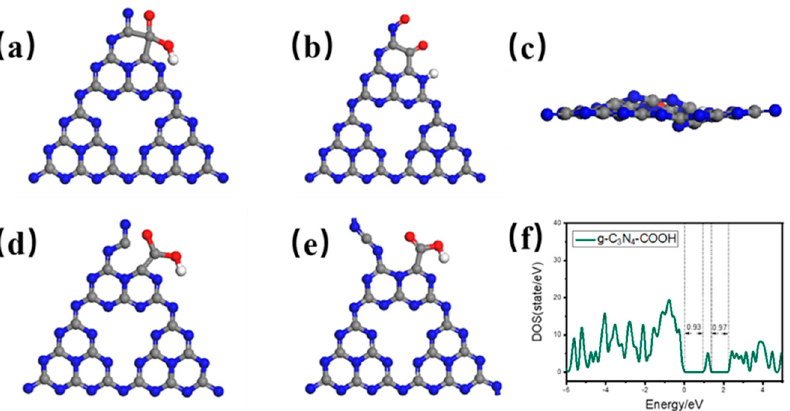
Figure 1. The DFT modeling closed-loop and open-loop structure of carboxyl-defective g-C 3 N 4 at N vacancy point defect site (gray, blue, pink and red spheres: C, N, Cu and O, respectively). ( a ) Original closed-loop configuration and ( b ) unsubstantiated structure after evolution with ( c ) 2D in-plane top view structure; ( d ) original open-loop configuration and ( e ) rational structure after evolution with ( f ) corresponding total density of states.